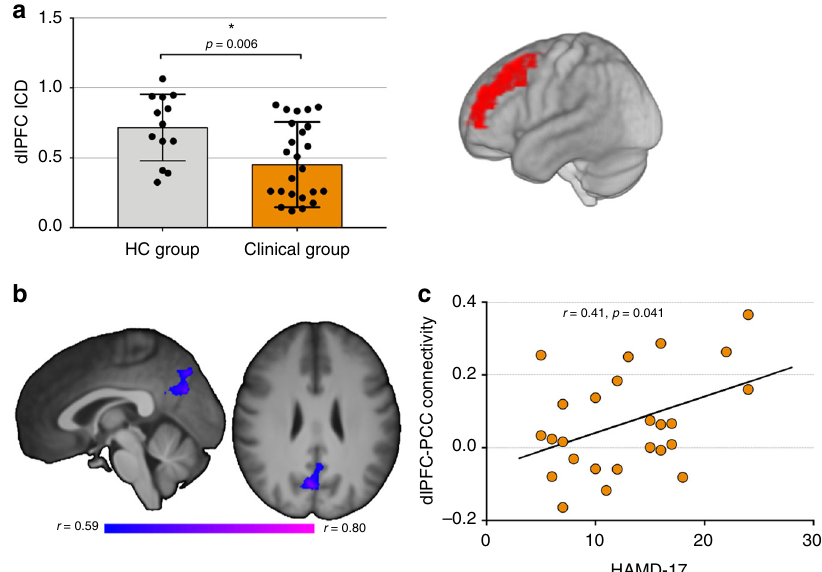
Fig. 3 Functional connectivity and combined connectivity/PET results. a Signi fi cantly lower dlPFC ICD connectivity in clinical ( n = 26) vs. HC group ( n = 13). Error bars represent standard deviation. dlPFC region displayed on right, subsequently used as seed. b Negative correlation between dlPFC-PCC connectivity and dlPFC SV2A density in the clinical group. Signi fi cant voxels represent those voxels whose connectivity with the dlPFC negatively correlates with [ 11 C]UCB-J V T in the dlPFC. c Positive correlation between dlPFC-PCC connectivity and severity of depressive symptoms. Correlations were computed using Pearson ’ s r . dlPFC: dorsolateral prefrontal cortex, PCC: posterior cingulate cortex, ICD: intrinsic connectivity distribution